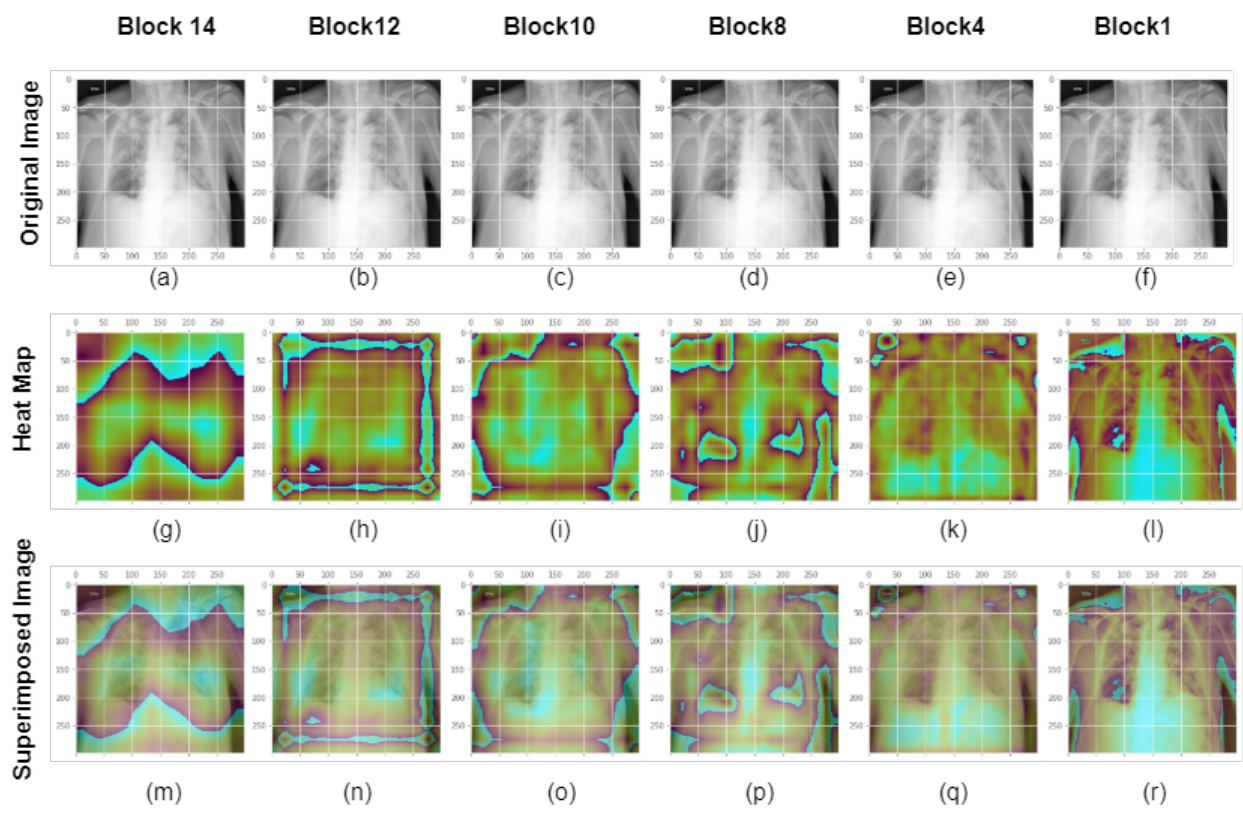
Figure 14. GradCam assessment of Xception-modeled class images at different levels. A chest X-ray picture from the COVID class is displayed in the first row or in images ( a – f ). The second row or images ( g – l ) displays the GradCam activation mapping for the X-ray picture. Images ( m – r ) or the third row: An activation map with an X-ray image overlaid to display the superimposed image. The block14 separation convolution 2 of the Xception model’s original picture, heatmap, and overlay image are shown in the first column. The second, third, fourth, fifth, and sixth columns correspond to Block 12 sepconv2, Block 10 sepconv2, Block 8 sepconv2, Block 4 sepconv2, and Block 1 conv1. Block 14 detects high-level features and influences decision-making, whereas block 1 detects lower-level features like colors and